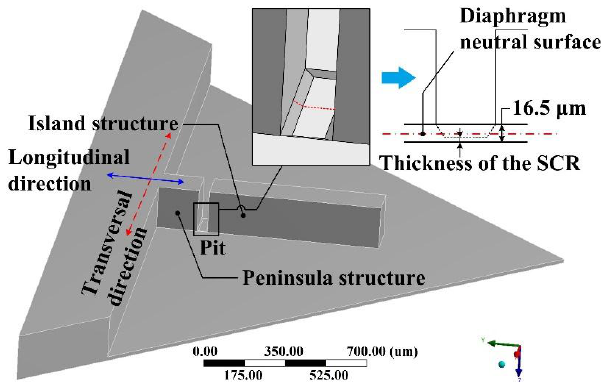
Figure 4. Diaphragm with peninsula-island structure and a pit.